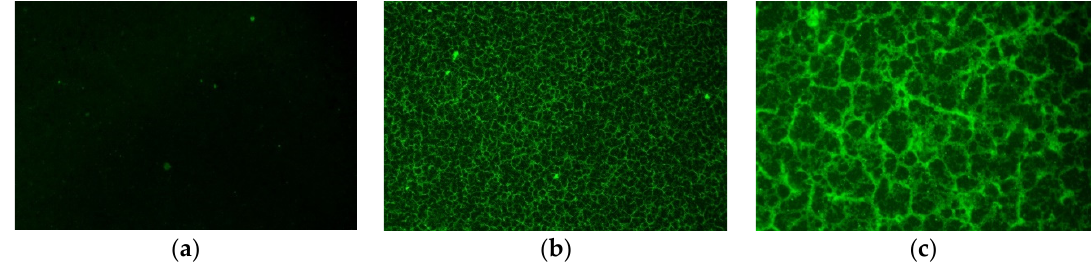
Figure 16. SBR-emulsified asphalt fluorescence microscope: ( a ) matrix-emulsified asphalt; ( b ) 100× magnification 3% SBR; ( c ) 400× magnification 3% SBR.